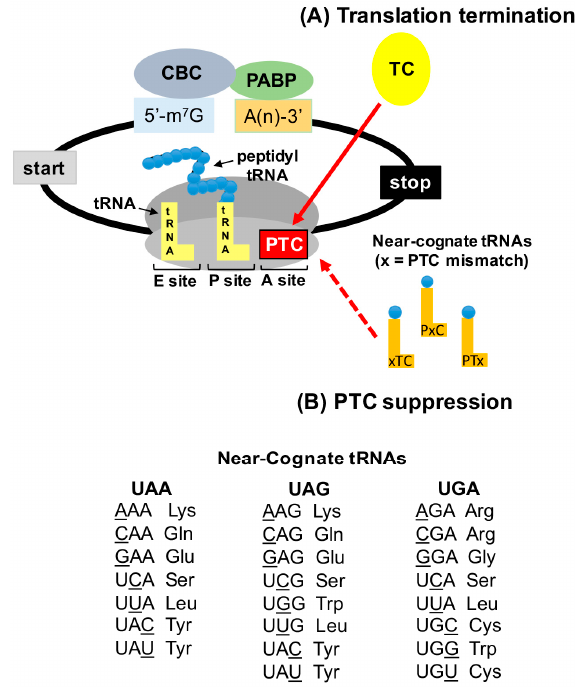
Figure 2. PTC suppression mechanism. ( A ) PTCs are recognized by the termination complex (TC), a process that is normally very efficient. ( B ) Near-cognate aminoacyl tRNAs (that base pair with two of the three nucleotides of the stop codon) can compete with eRF1 for PTC binding in the ribosomal A site. Accommodation of near-cognate aminoacyl tRNAs allows an amino acid to become incorporated into the nascent polypeptide at the site of the PTC, allowing translation to continue in the correct ribosomal reading frame to generate a full-length polypeptide. The “x” depicted in the schematic of near-cognate tRNAs indicates the nucleotide position of the PTC that is non-cognate to the near-cognate tRNA (xTC = first nucleotide, PxC = second nucleotide, and PTx = third nucleotide). The aminoacyl tRNAs that are near-cognate to stop codons are shown.